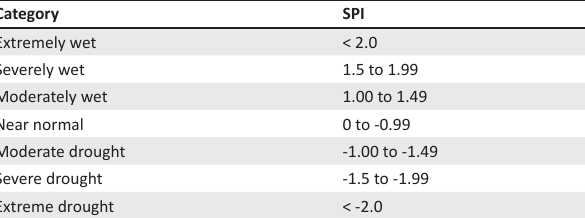
TABLE 1: Categories of the Standardised Precipitation Index based on the Standardised Precipitation Index